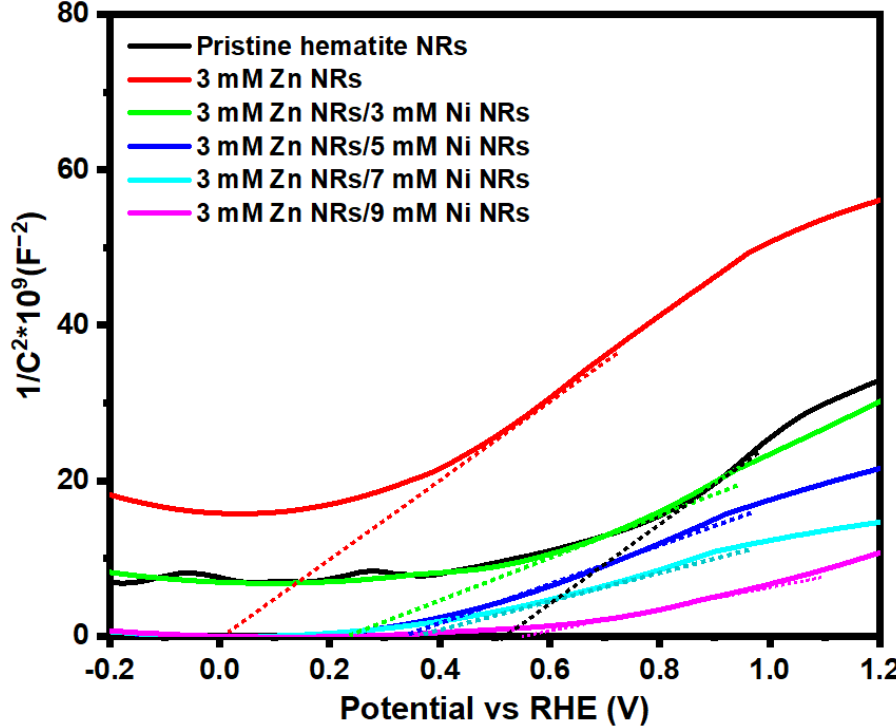
Figure 10. Mott–Schottky spectra of seeded hematite NRs co-doped with different Zn/Ni concentra- tions.